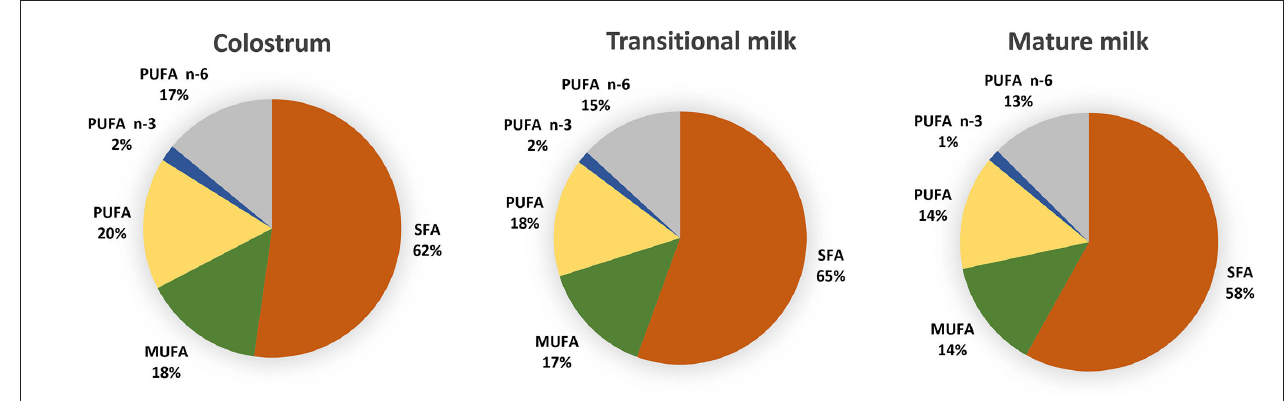
FIGURE 2 | Distribution of fatty acids categories in colostrum (1–7 days), transitional milk (8–15 days) and mature milk (15–60 days) after pooled data analysis of worldwide milk samples reported by Floris et al. (28). (PUFAs) polyunsaturated fatty acids; (n-3 PUFAs) n-3 polyunsaturated fatty acids; (n-6 PUFAs) n-6 polyunsaturated fatty acids; (MUFA) monounsaturated fatty acids; (SFA) saturated fatty acids and (MCFA) medium chain fatty